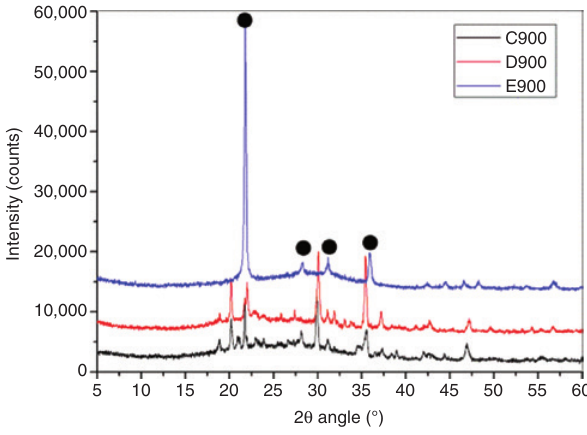
Figure 8: XRD pattern of C900, D900 and E900 ( • : low cristobalite (SiO )). 2